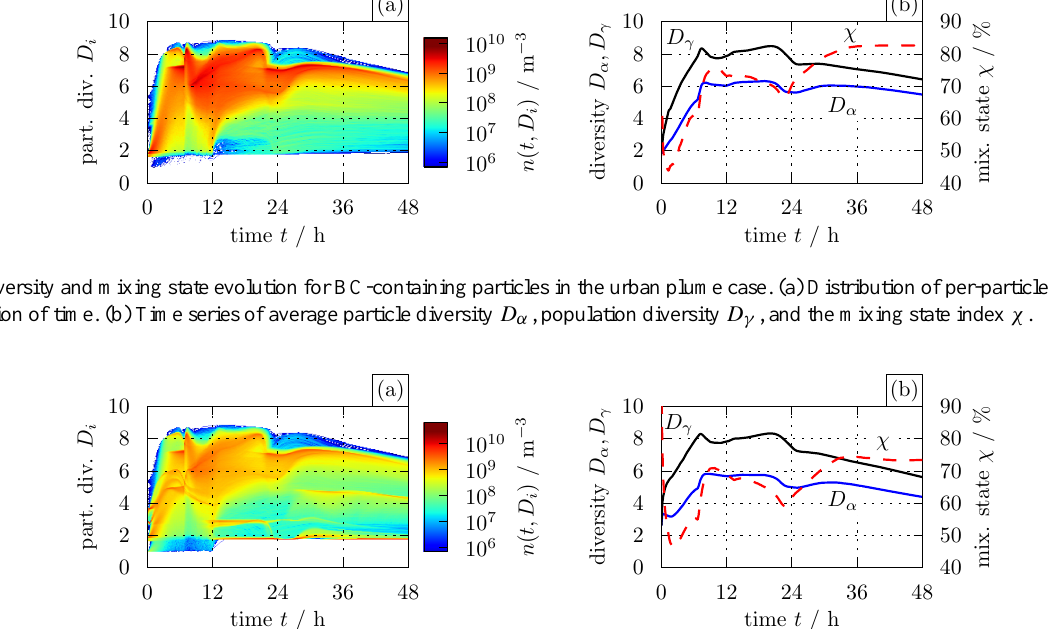
Fig. 3: Particle diversities D i of representative particles. The particle diversity measures the effective number of species within a particle, so a pure single-species particle has D i = 1 and a particle consisting of 2 or 3 species in even proportion will have D i = 2 or D i = 3 , respectively. A particle with un- equal amounts of 2 species will have an effective number of species somewhat less than 2, while a particle with unequal amounts of 3 species will have effective species below 3, and possibly even below 2 if the distribution is very unequal. Fig. 9. Mixing state diagram for urban plume case showing the pop- ulation species diversity D γ versus the average particle species di- versity D α for the urban plume case presented in Fig. 8 (all particles included).